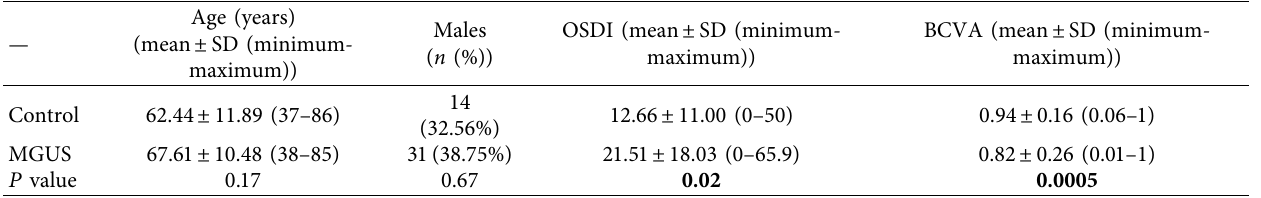
Table 1: Age, gender, Ocular Surface Disease Index (OSDI) score, best-corrected visual acuity (BCVA) in control subjects and in patients with monoclonal gammopathy